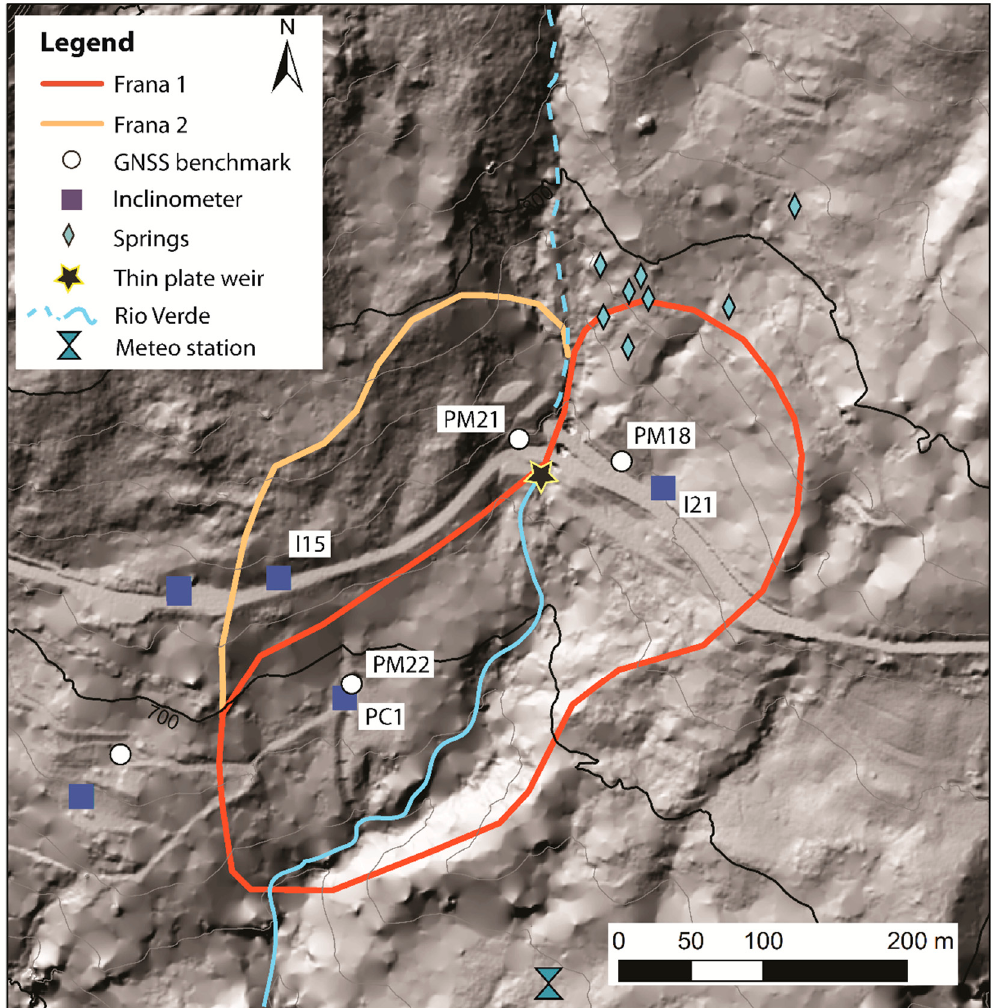
Figure 2. Frana 1-2 with active monitoring devices at the time of writing, location of the springs and location of the thin plate weir that measures the discharge of the Rio Verde stream. The I21 and PC1 superscriptions represent, respectively, the location for inclinometers I21, I21bis and I21ter, and of PC1, PC1bis and PC1ter.